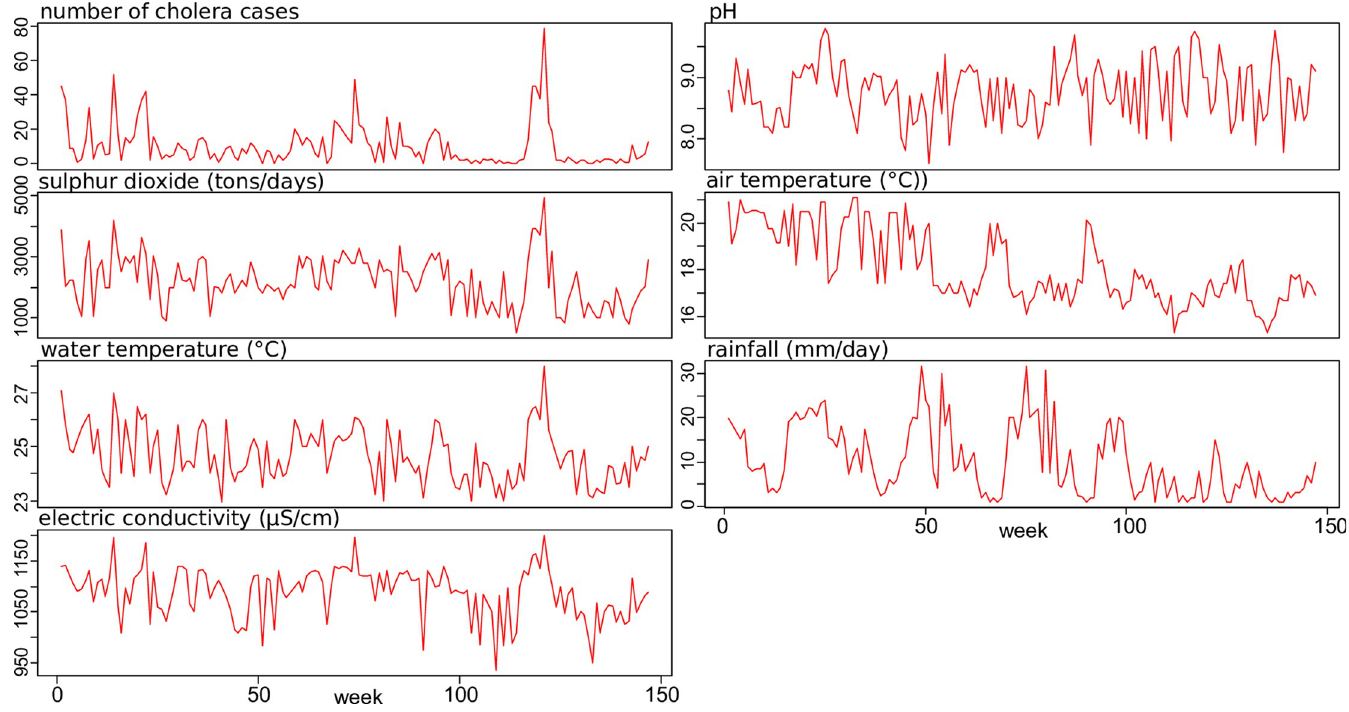
Fig 2. Time series plot of cholera cases and environmental variables for the period of 2007 to 2012, Katana health zone, DR Congo (n = 147).